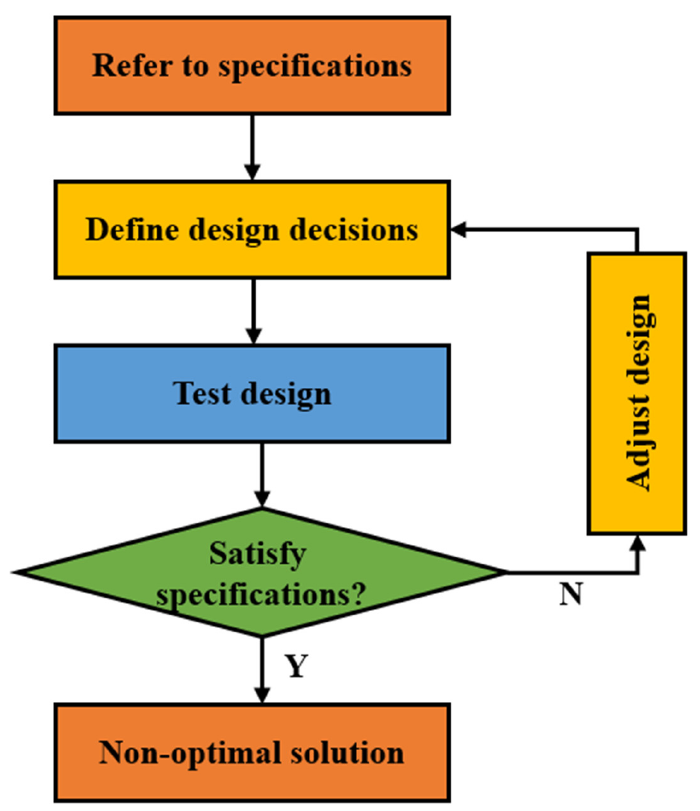
Figure 1. Prescriptive-based approach.